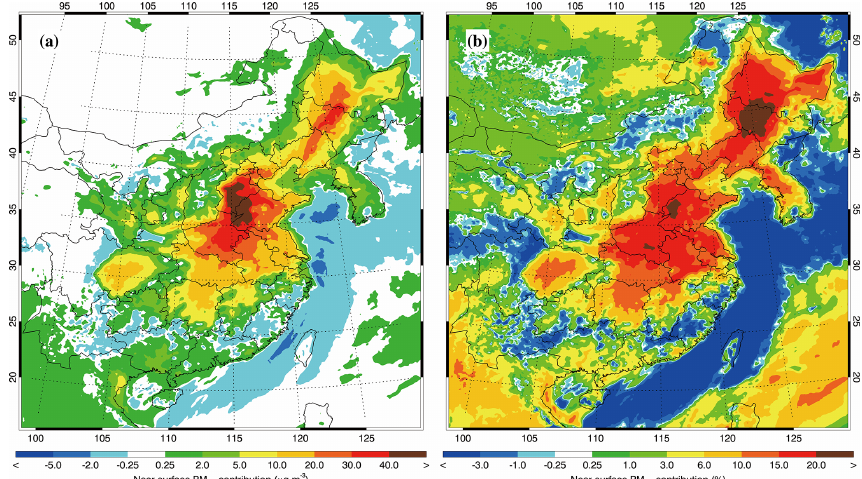
Figure 14. Average near-surface (a) absolute and (b) relative PM 2 . 5 contribution caused by the ALW-HET from 5 December 2015 to 4 January